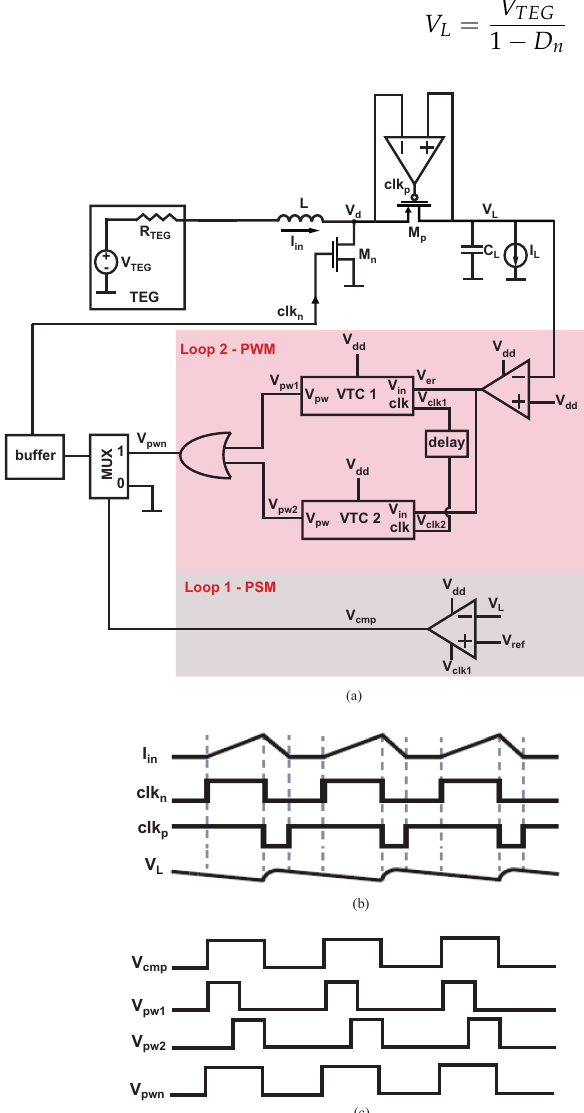
Figure 5. ( a ) Block diagram of the SI DC–DC boost regulator using VTC circuit as a pulse width modulation scheme. When V L < V ref , V cmp = 1 and V pwn is passed to M n . Once V L equals V ref , M n turns off and the active diode, M p , controlled by a comparator turns on. When I in reaches zero, M p turns off. ( b ) output waveform of the SI boost regulator, ( c ) output waveform of PWM and